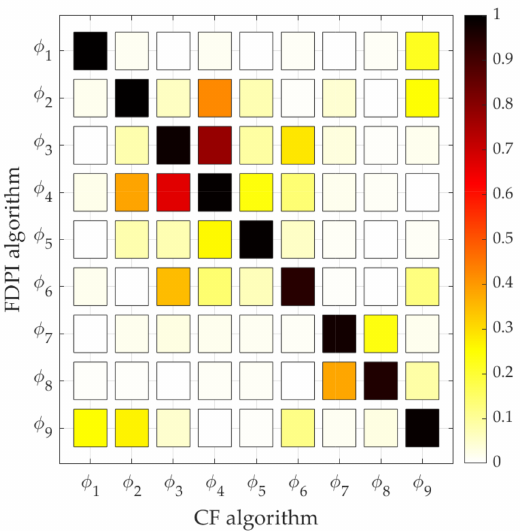
Figure 8. MAC matrix computed by comparing the mode shapes estimated through the CF algorithm (horizontal axis) and the FDPI algorithm (vertical